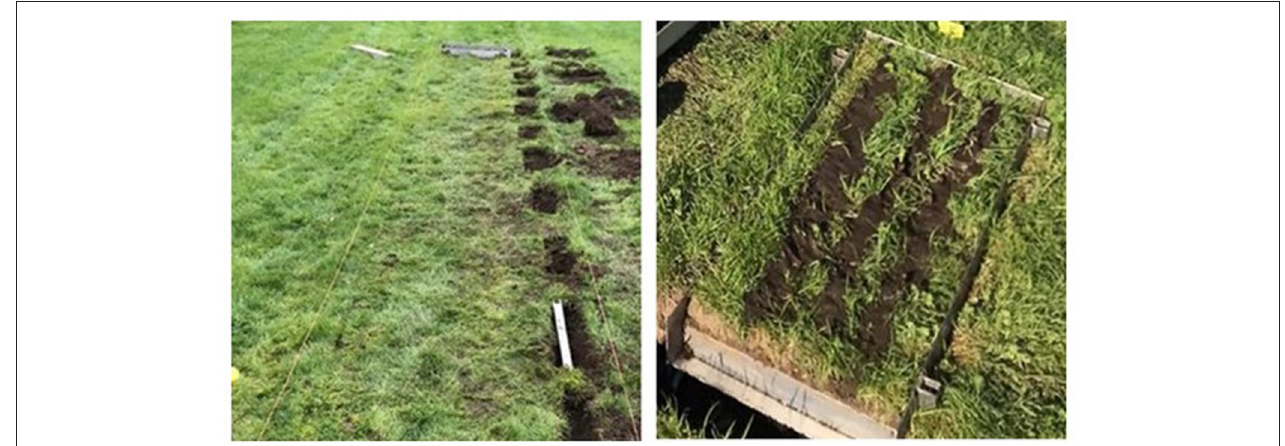
FIGURE 1 | The layout of the micro-plots (left) and a micro-plot with the aluminium frame and collection channel installed (right).